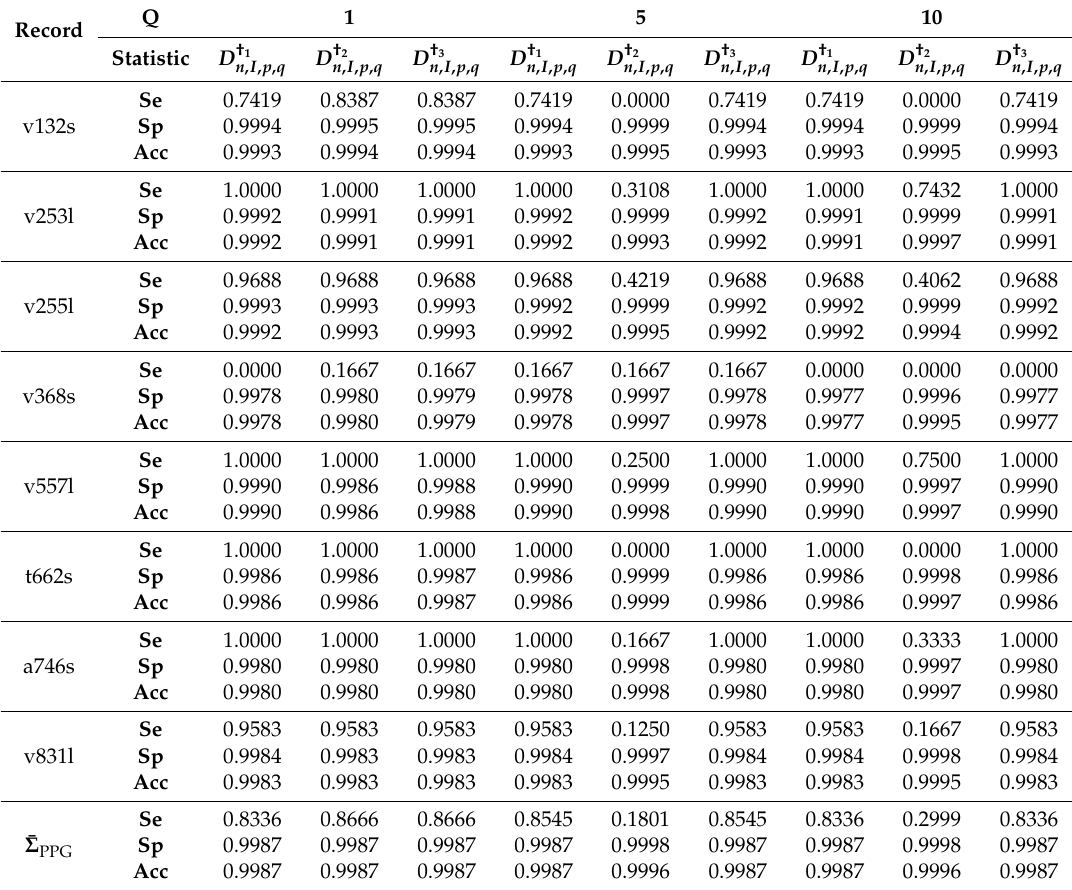
Table 2. Detection performance of l-SSA-CPD on PC15 PPG